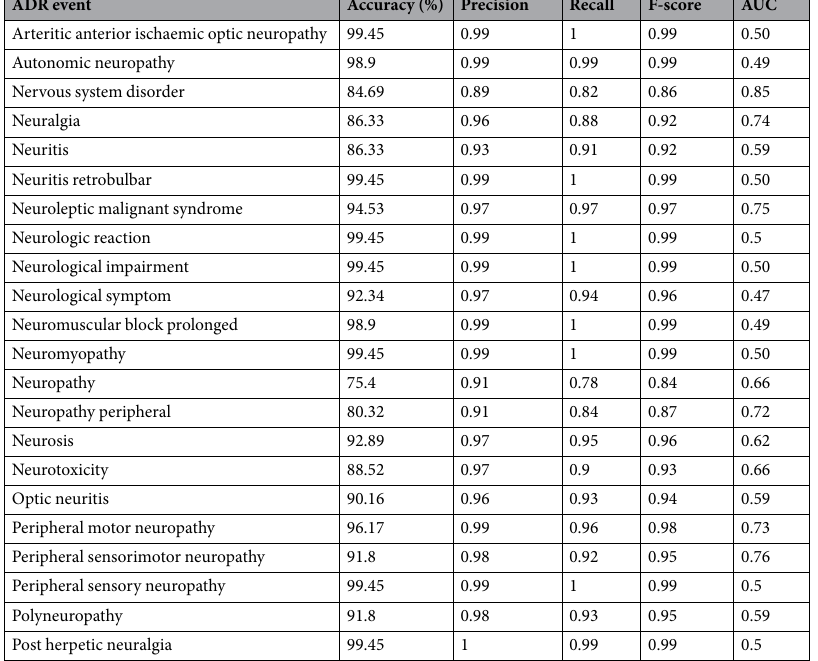
Table 7. Provides the performances of the models generated using the Biological + Phenotypic features.